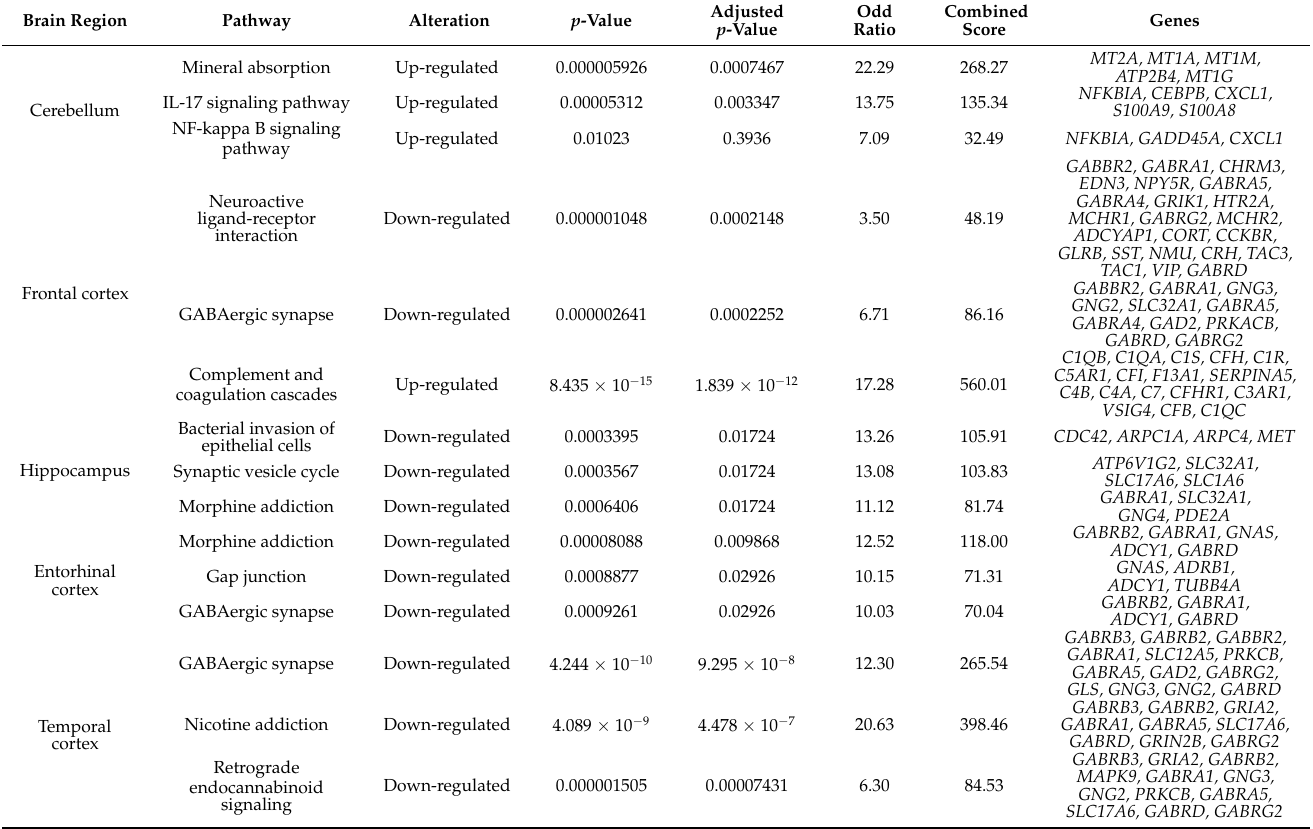
Table 2. The top three enriched pathways by robust DEGs in each brain region, determined using Enrichr and